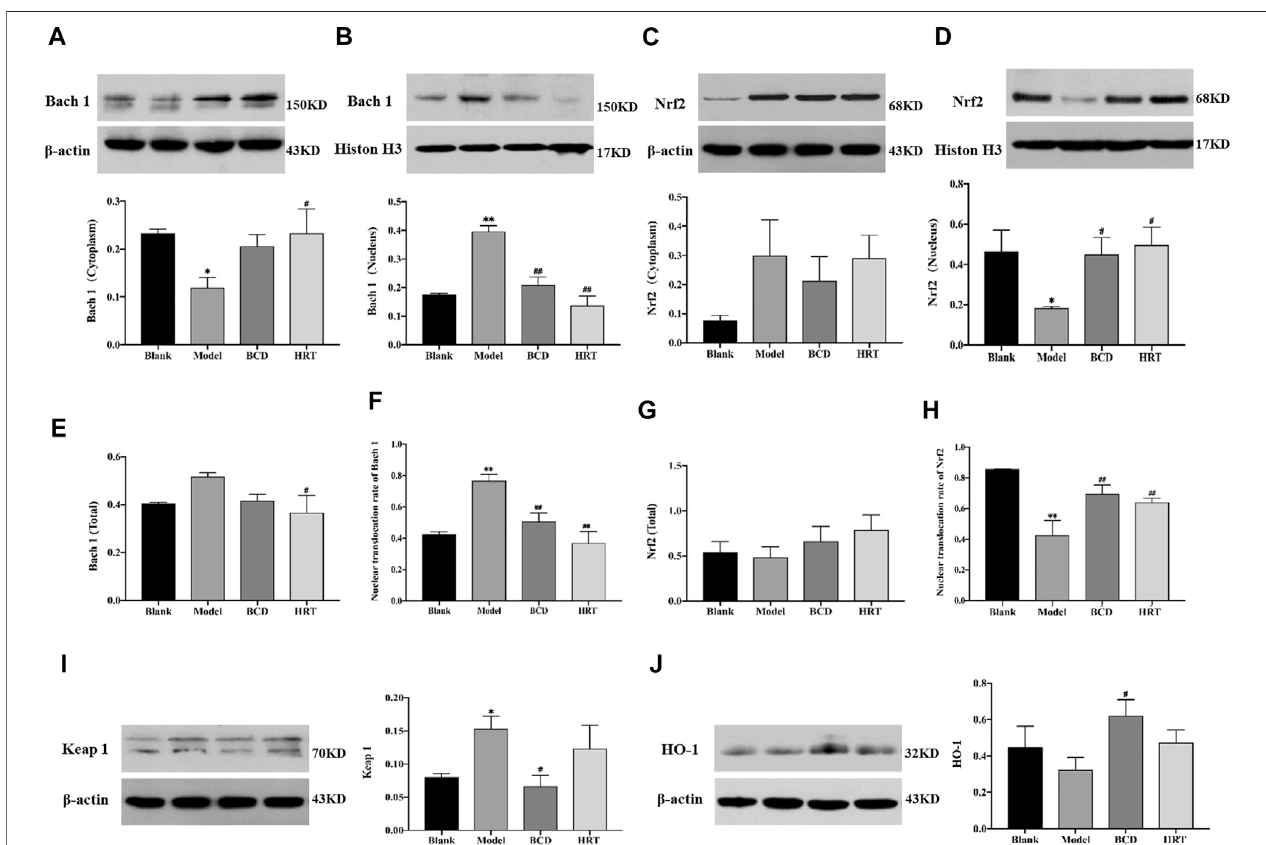
FIGURE 7 | BCD facilitates nuclear translocation of Nrf2 in TWP-induced POI mice ovaries. Western blot experiments on Nrf2/Keap 1 pathway proteins were carried out. The relative protein concentrations were visualized with the ImageJ 6.0 software program. Relative quantities of Bach 1 localized in cytoplasm (A) and in nucleus (B) . The relative intensities ofNrf2 localized in cytoplasm (C) and in nucleus (D) . The total content ofBach 1 (E) , and the nuclear translocation rate ofBach 1 (F) . The totalcontentofNrf2 (G) ,and thenucleartranslocation rateofNrf2 (H) . Therelativeintensities ofKeap1 (I) and HO-1 (J) . All dataisacombination ofeight mice fromeachgroup.Thedataisvisualizedintermsofmeans±SEM.(* p < 0.05,** p < 0.01,comparedwiththeBlankgroup; # p < 0.05, ## p < 0.01,comparedwiththeModel